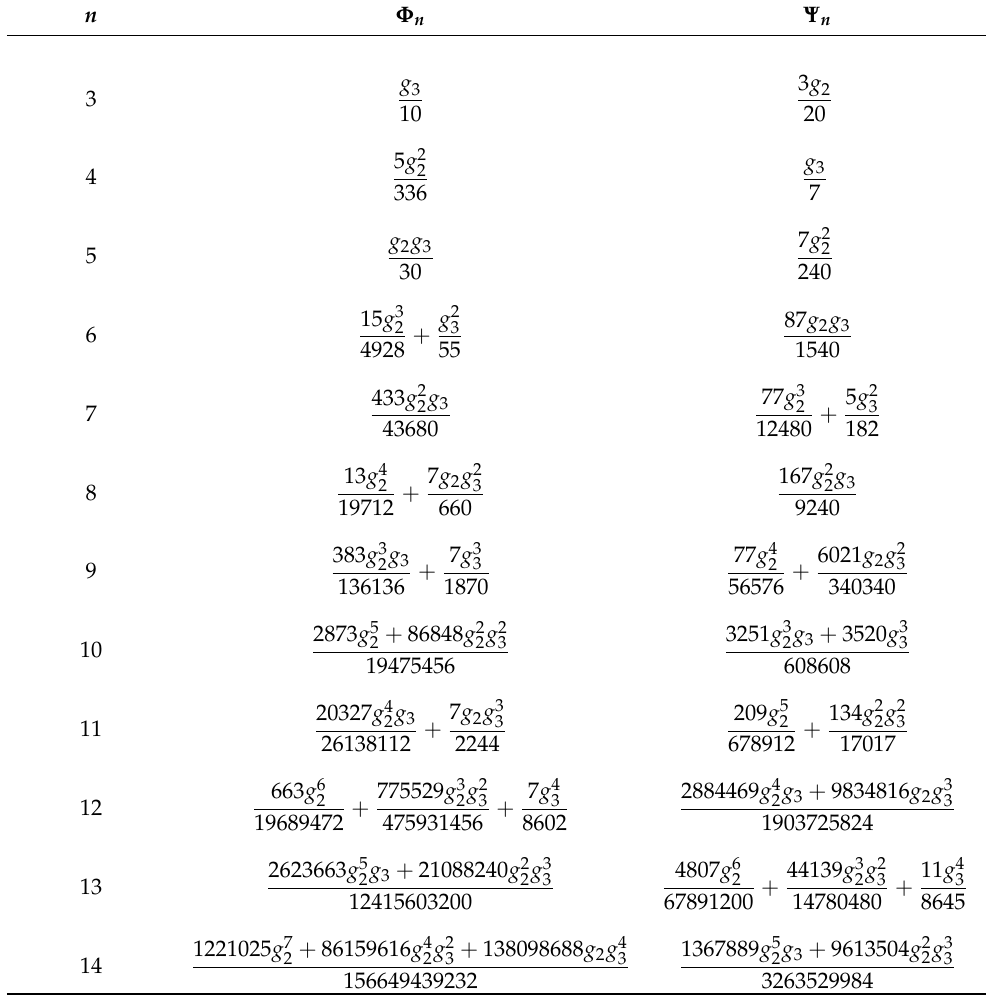
Table 2. Table of Φ n and Ψ n for n ≤